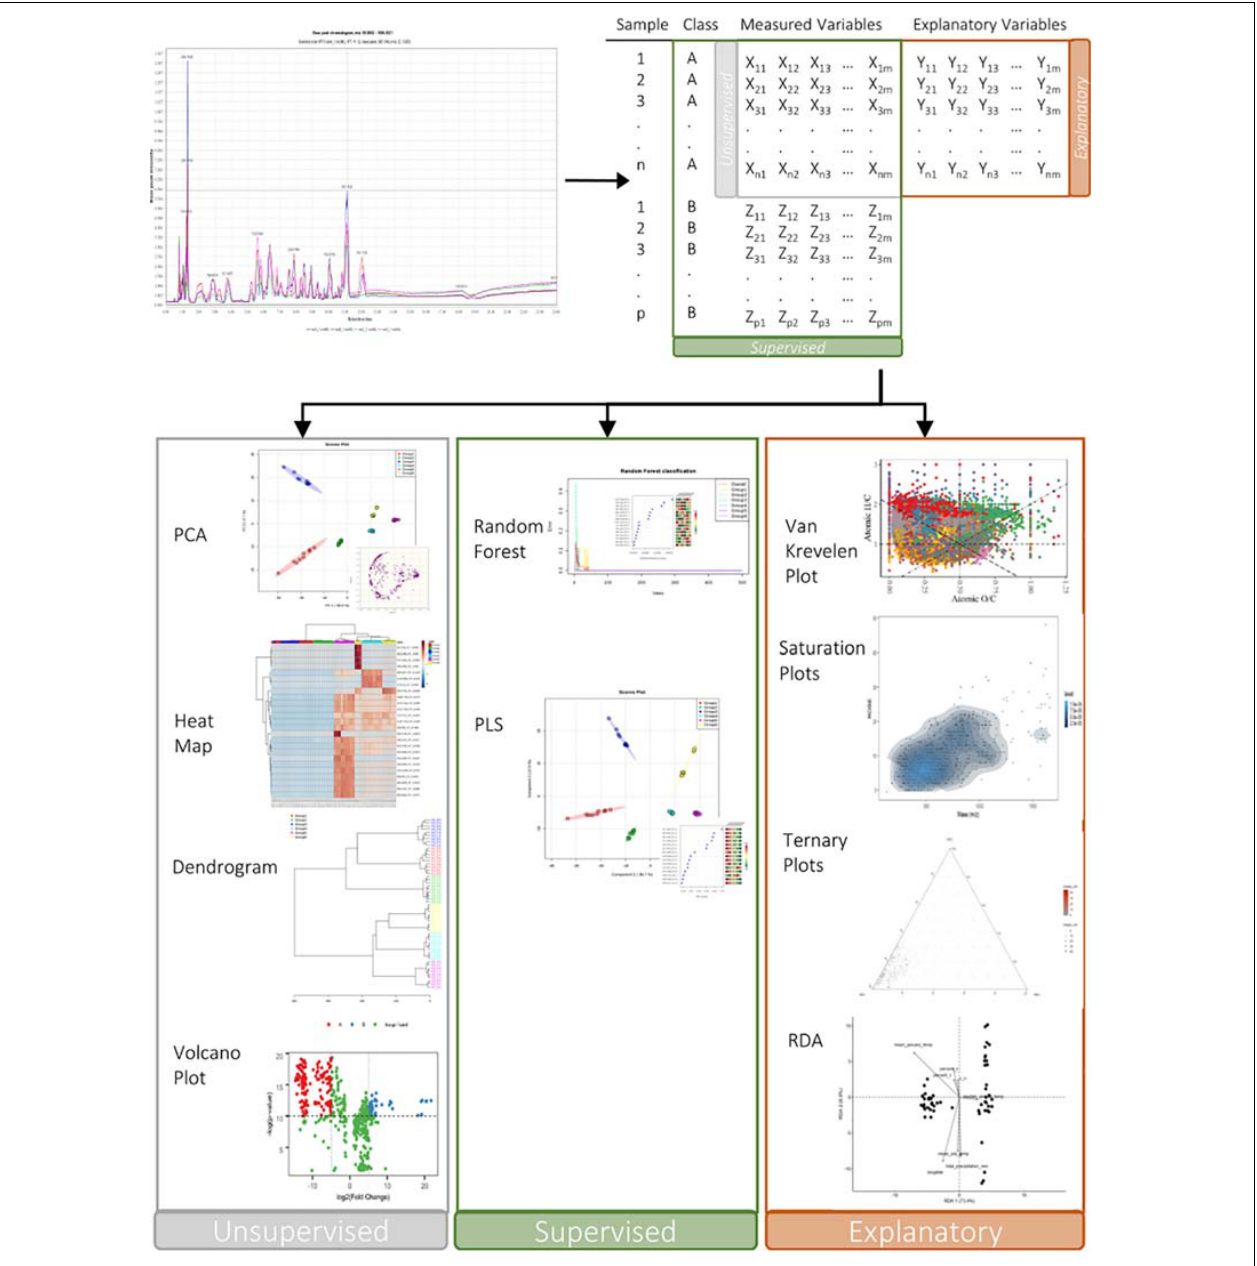
FIGURE 3 | Application of untargeted or semi-targeted metabolomics analysis of SOM provides insight into physiochemical and biological drivers of SOM stabilization and mineralization. Untargeted metabolite profiling is intended to have maximal coverage of chemical space; whereas semi-targeted analyses focus on a specific molecular class or range of classes (e.g., N containing compounds, or fatty acids). During data processing (i.e., of an LC-MS dataset), mass spectral chromatograms [three-dimensional data: retention time, m/z range (50–2000 Da), relative signal abundance] are converted into two-dimensional data matrices through data preprocessing software, followed by multivariate and univariate statistical analysis (unsupervised, supervised, and molecular fingerprinting